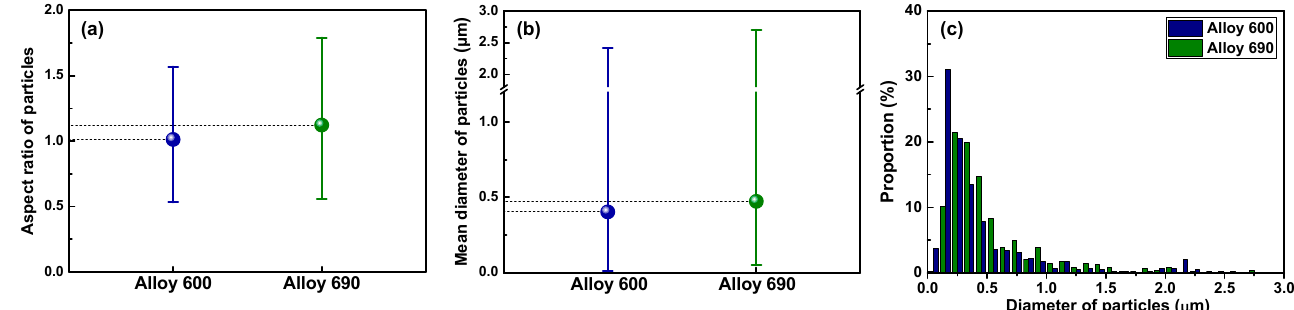
Figure 7. Deposit analysis of 300 randomly selected deposit particles: ( a ) aspect ratio, ( b ) mean diameter, and ( c ) size distribution.